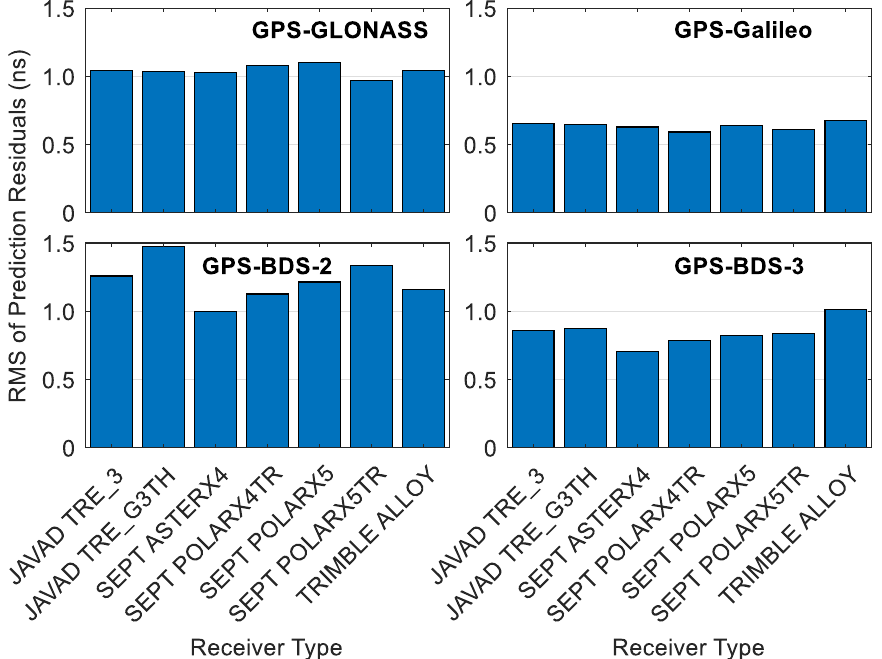
Figure 10. RMS statistics of prediction residuals of daily ISBs with a time span of prediction of a day for each receiver type.